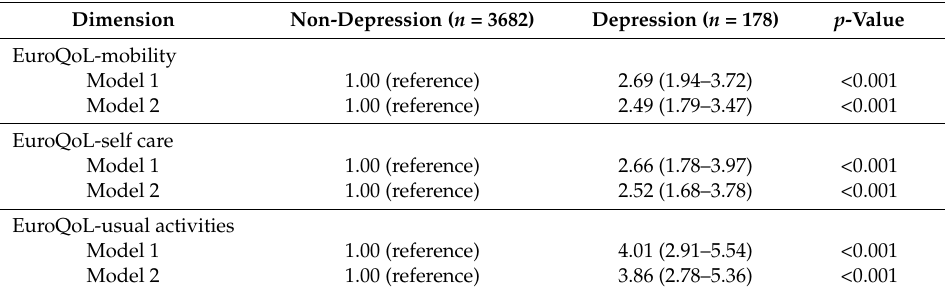
Table 4. Adjusted odds ratios (OR, 95% CIs) for disability for the EuroQol categories in postmenopausal